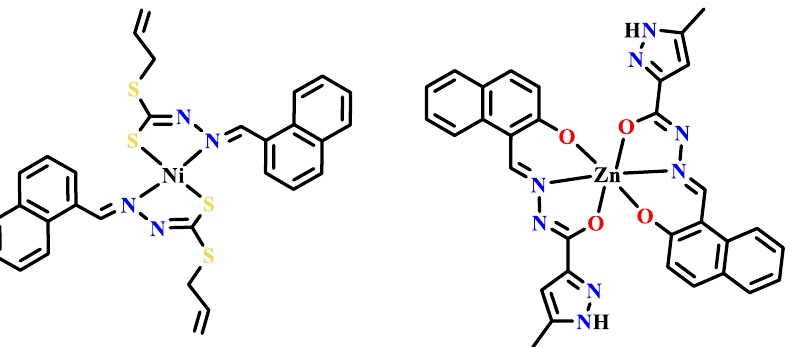
Figure 26. The symmetric Ni(II) and Zn(II) complexes coordinated by the same two naphthylhydra- zone ligands with S -allyldithiocarbazate or methylimidazolamide as side chains.